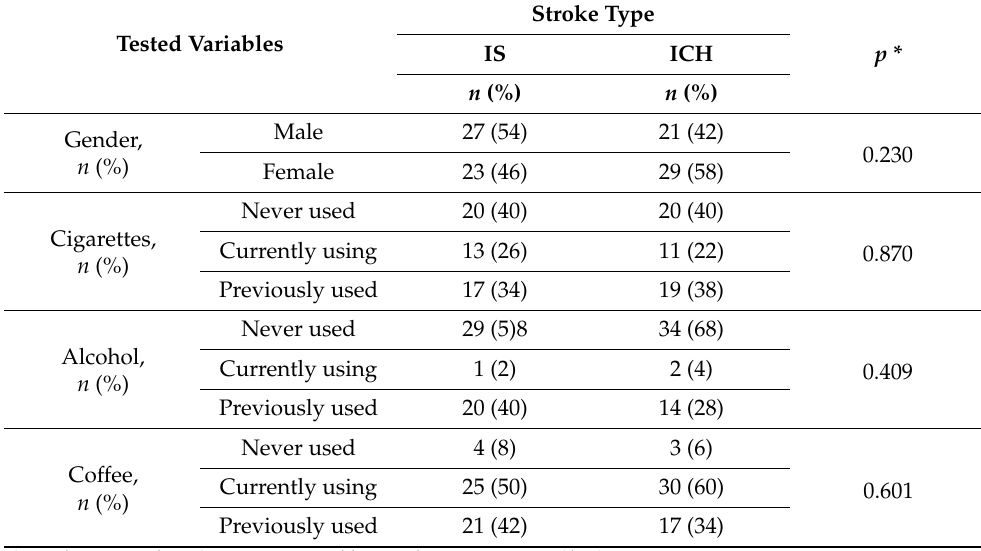
Table 3. Statistical interpretation of tested variables with regards to the stroke